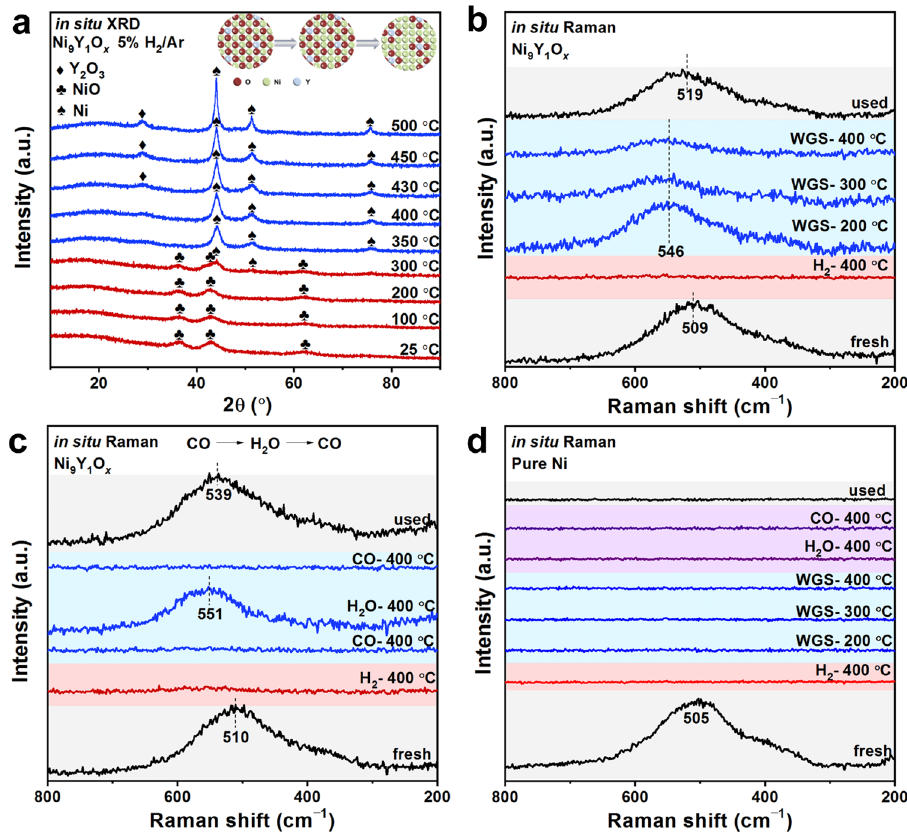
Fig. 4 In situ characterizations to monitor the interfacial structure changing. a In situ XRD patterns in 5% H 2 /Ar for the Ni 9 Y 1 O x catalyst; in situ Raman spectra under the WGS reaction conditions for ( b , c ) Ni 9 Y 1 O x catalyst and ( d ) pure Ni